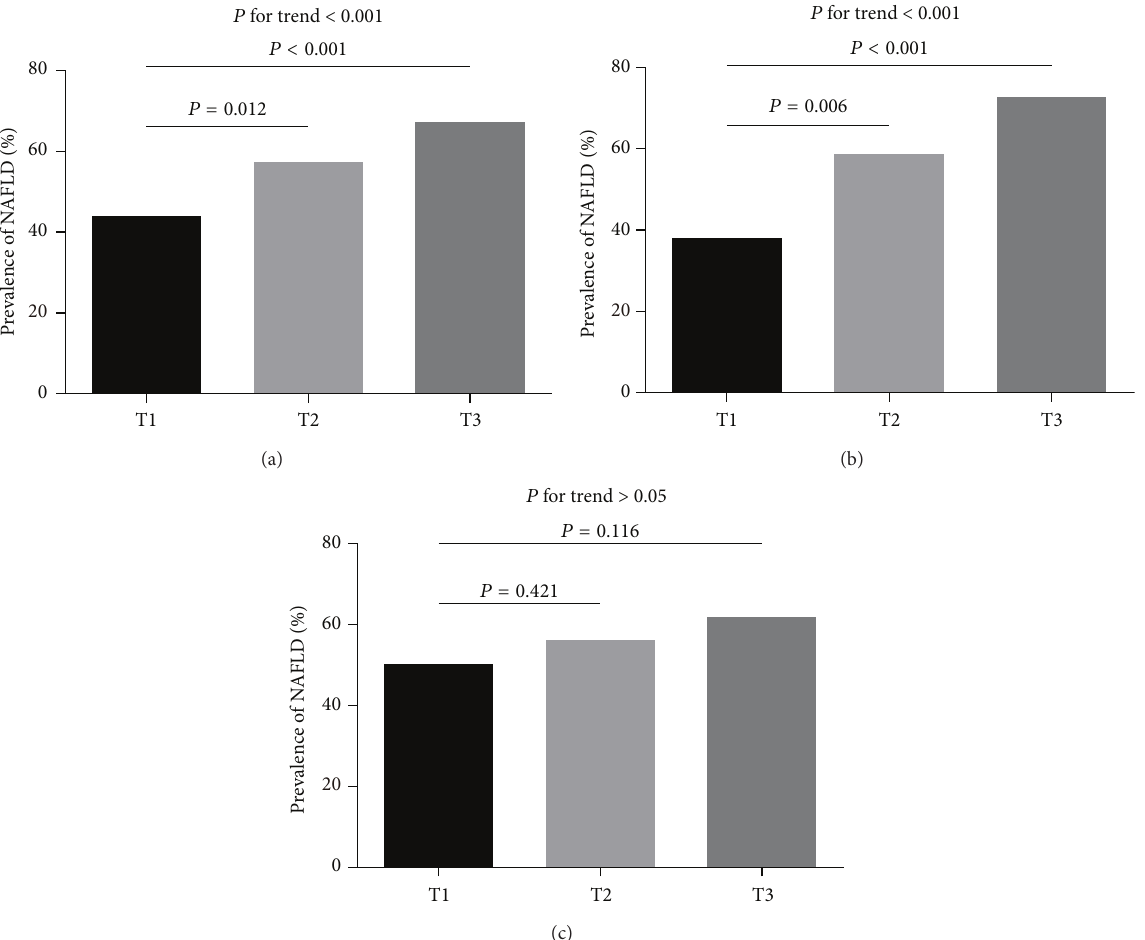
Figure 1: Prevalence of NAFLD according to tertiles of SUA. T1, T2, and T3 represent tertile 1, tertile 2, and tertile 3 of SUA in total subjects (a), in men (b), and in women (c),